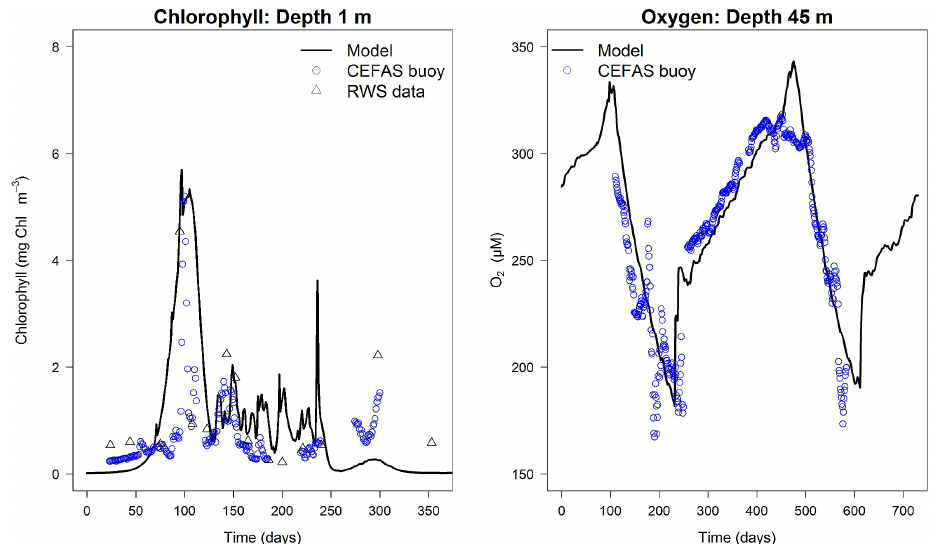
Fig. 5. The left panel shows a comparison between chlorophyll concentration calculated by the coupled benthic–pelagic model (black solid line) and the concentration measured by the CEFAS buoy (blue points) and Rijkswaterstaat (RWS) monthly monitoring data (black triangles) for a simulation of the year 2007. The right panel shows the calibration result of the oxygen concentration at a depth of 45m for the period